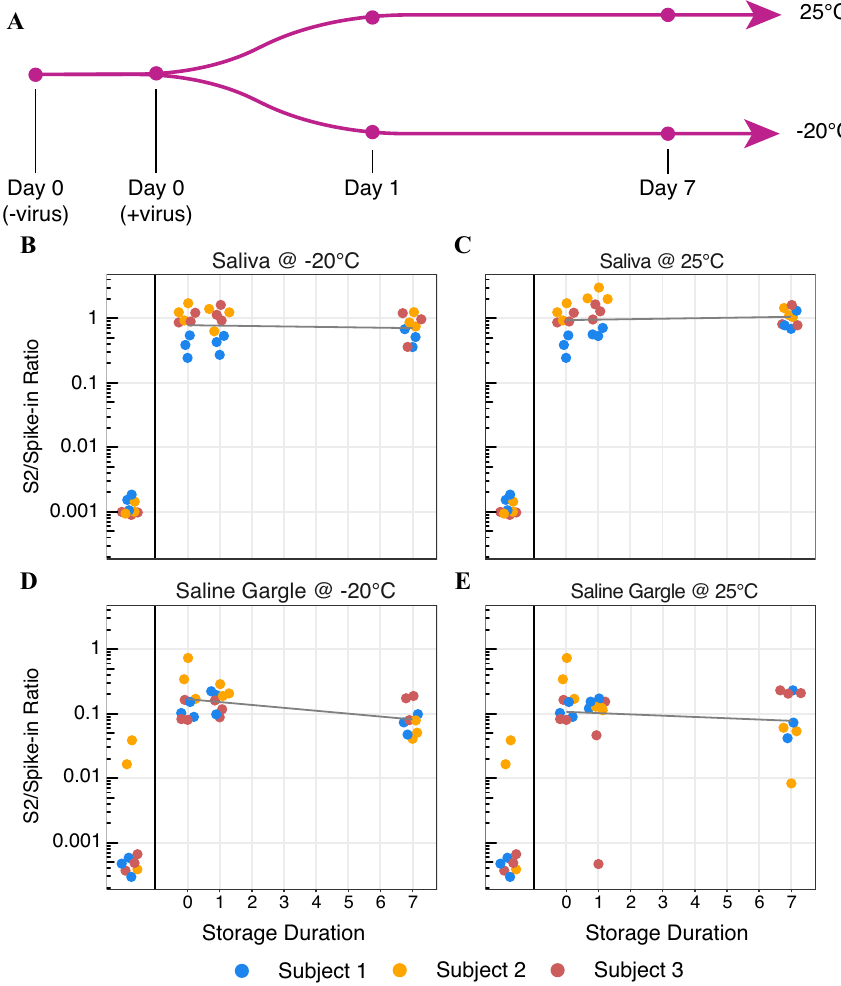
Figure 5. Stability of virus in saliva and saline gargle as assessed by Swab-Seq. ( A ) Schematic of virus stability study design. Saliva and saline gargle samples were collected from three individuals and inactivated virus was spiked-in such that the final PCR would contain 250 copies of the viral genome. The samples were then aliquoted and stored at 25 °C or − 20 °C for the indicated amount of time, at which point the sample was heated and stored. ( B – E ) Swab-Seq50 results for each time course: ( B ) saliva at − 20 °C, ( C ) saliva at 25 °C, ( D ) saline gargle at − 20 °C, and ( E ) saline gargle at 25 °C. Each sample was tested in triplicate. For each sample type (i.e. saliva and saline gargle), a single set of negative control samples and Day 0 samples were set up as reference for both storage conditions, so the data points for the negative and Day 0 controls are reproduced exactly in both panels. X-axis indicates storage duration in days, y-axis indicates S2/Spike-in ratio, and color of the point indicates the